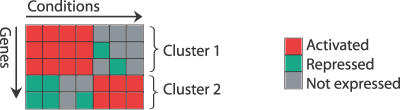
Clustering MethodsGenes that share similar expression profiles across conditions are grouped together by clustering.